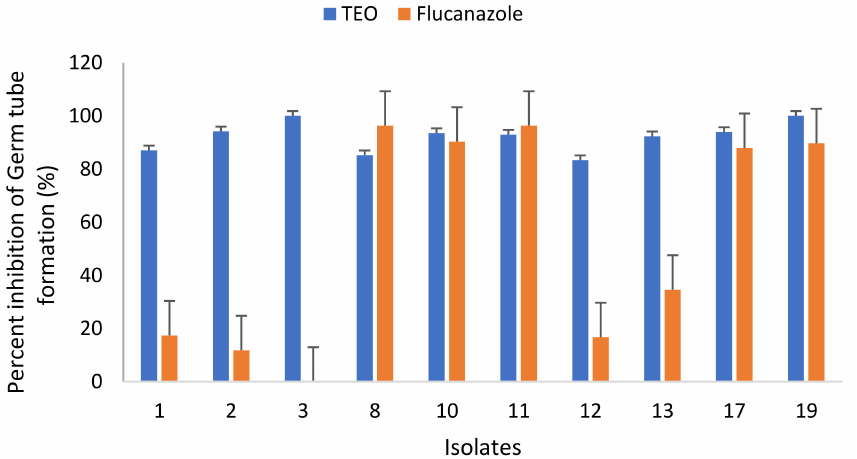
Figure 6. Percent inhibition of germ tube formation of C. albicans incubated at sub-inhibitory concen- trations (1/2 × MIC) of the Thyme essential oil